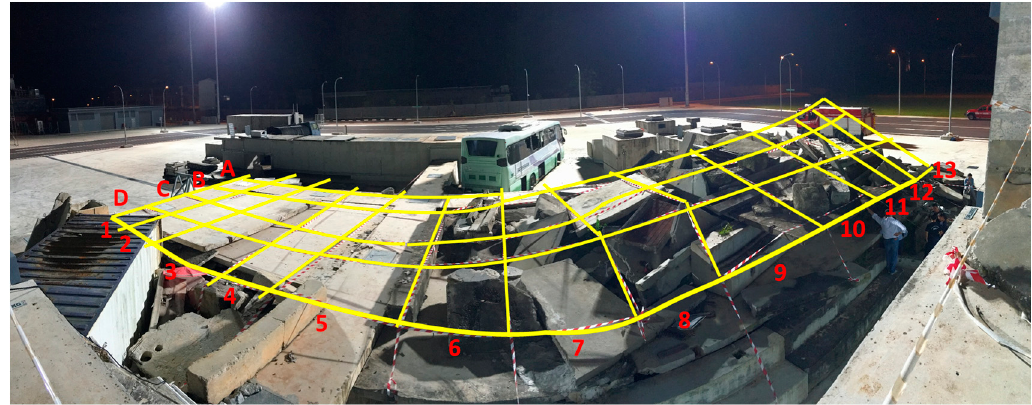
Figure 3. Experiment environment (panorama image).